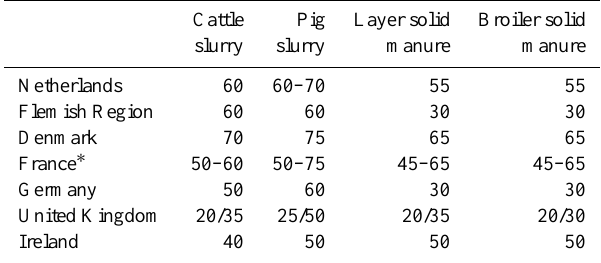
Table 9. Statutory nitrogen fertilizer equivalency (%) for applica- tion of most common manure types (after deduction of gaseous losses from buildings and storage; taken from Webb et al., 2013).